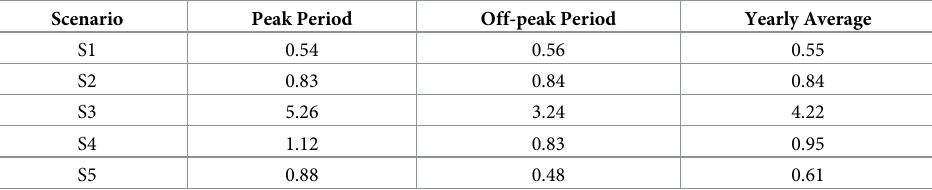
Table 10. Average waiting times per trip of yard trucks (YTs) in scenarios S1–S5